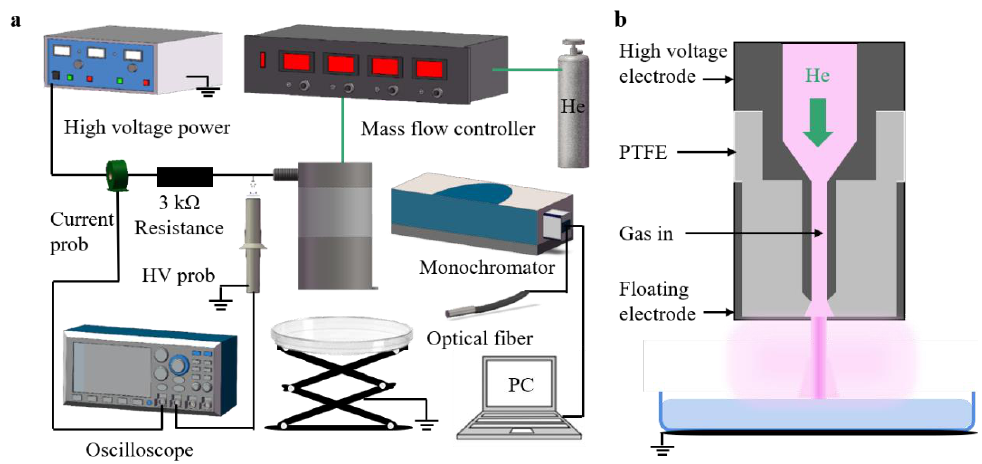
Figure 1. Experiment setup of FEGLD plasma with ( a ) experiment schematic and ( b ) discharge reactor diagram.